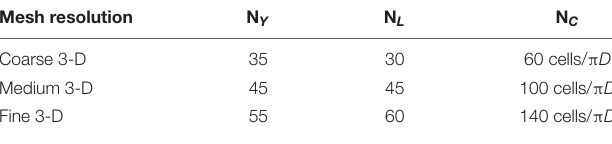
TABLE 2 | Grid parameters for mesh convergence study of the 3-D